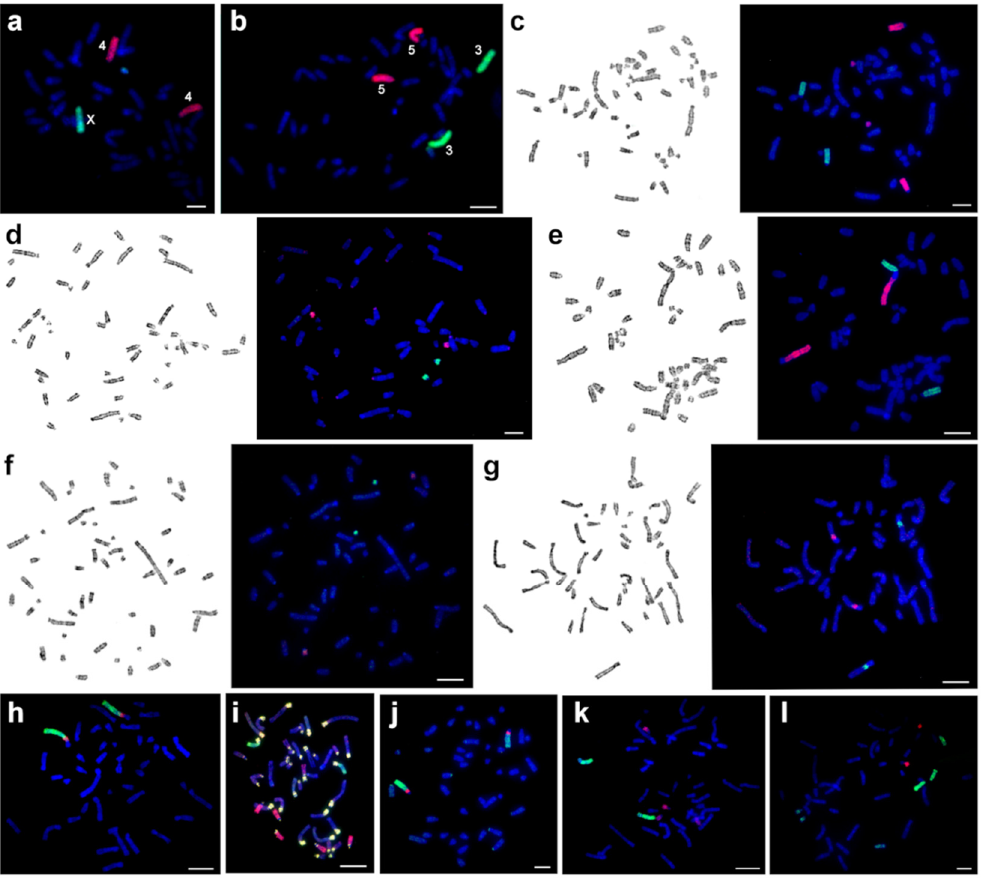
Figure 7. Examples of fluorescent in situ hybridization of chromosome-specific probes onto chromosomes of different Calomyscus specimens: ( a ) chromosomes X (green) and 4 (red) of CSP17m onto CSP17m; ( b ) chromosomes 3 (green) and 5 (red) of CSP17m onto CSP17m; ( c ) chromosomes 6 (green) and 4 (red) of CSP17m onto CSP1m; ( d ) microdissection-derived probes C7 (red) and C8 (green) onto CSP1m; ( e ) chromosomes 1 (red) and 6 (green) of CSP17m onto CSP3m; ( f ) microdissection-derived probes C5 (green) and C6 (red) onto CSP3m; ( g ) microdissection-derived probes C7 (red) and C8 (green) onto CELB3m; ( h ) chromosomes 2 (green) and 21 (red) onto CELB1f; ( i ) chromosomes 7 (green) and 11 + 13 + 14 (red) onto CELB1f; ( j ) chromosomes 1 (green) and 21 (red) onto CMYS2m; ( k ) chromosomes 7 (green) and 19 + 20 (red) onto CBAI1f; ( l ) chromosomes 10 + 12 + 19 (green) and 21 (red) onto CSP18f. CBAI— C. bailwardi, CELB— C. elburzensis, CMYS— C. m. mystax, CSP— Calomyscus sp.. Scale bar is 10 µm.